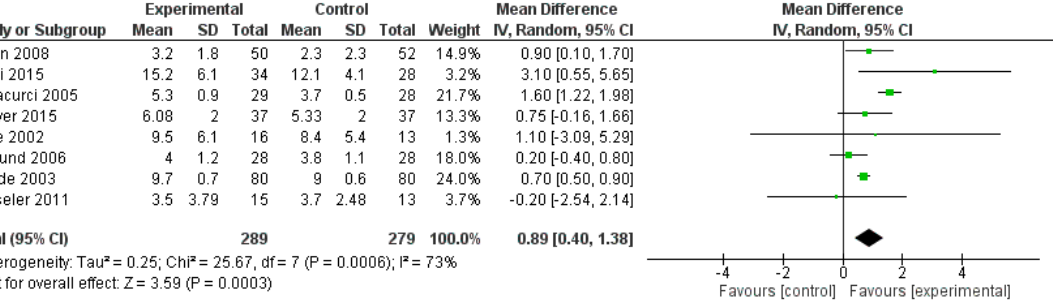
Figure 6. Pooled analysis of association between polyphenol intake and flow mediated dilation (FMD).